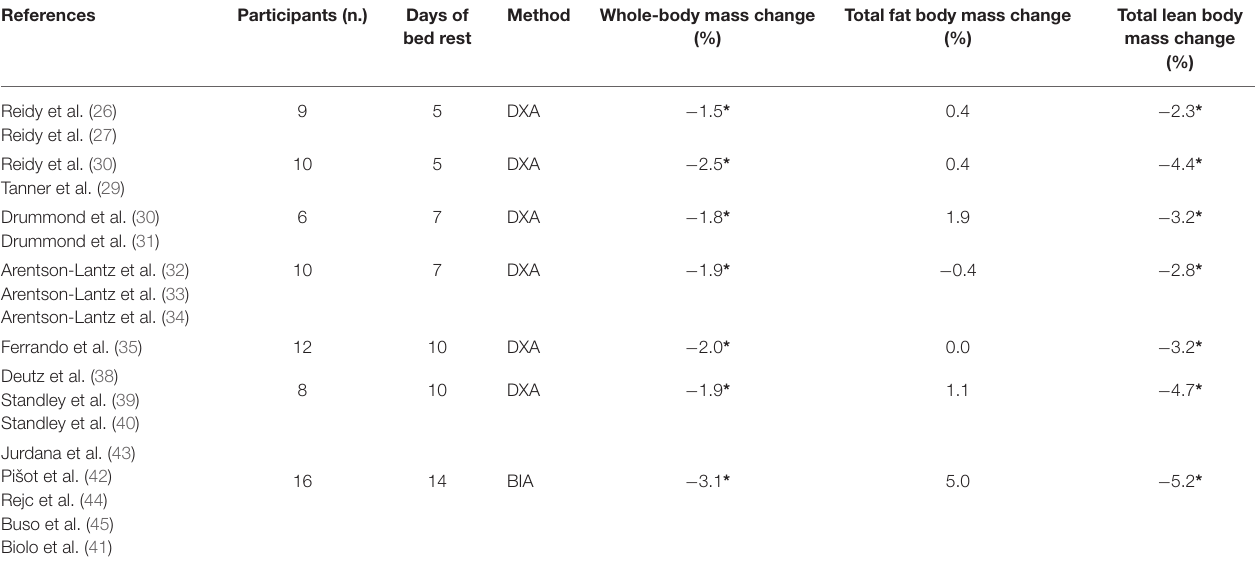
TABLE 3 | Time-related bed rest induced body composition relative change (%) in healthy older adults.